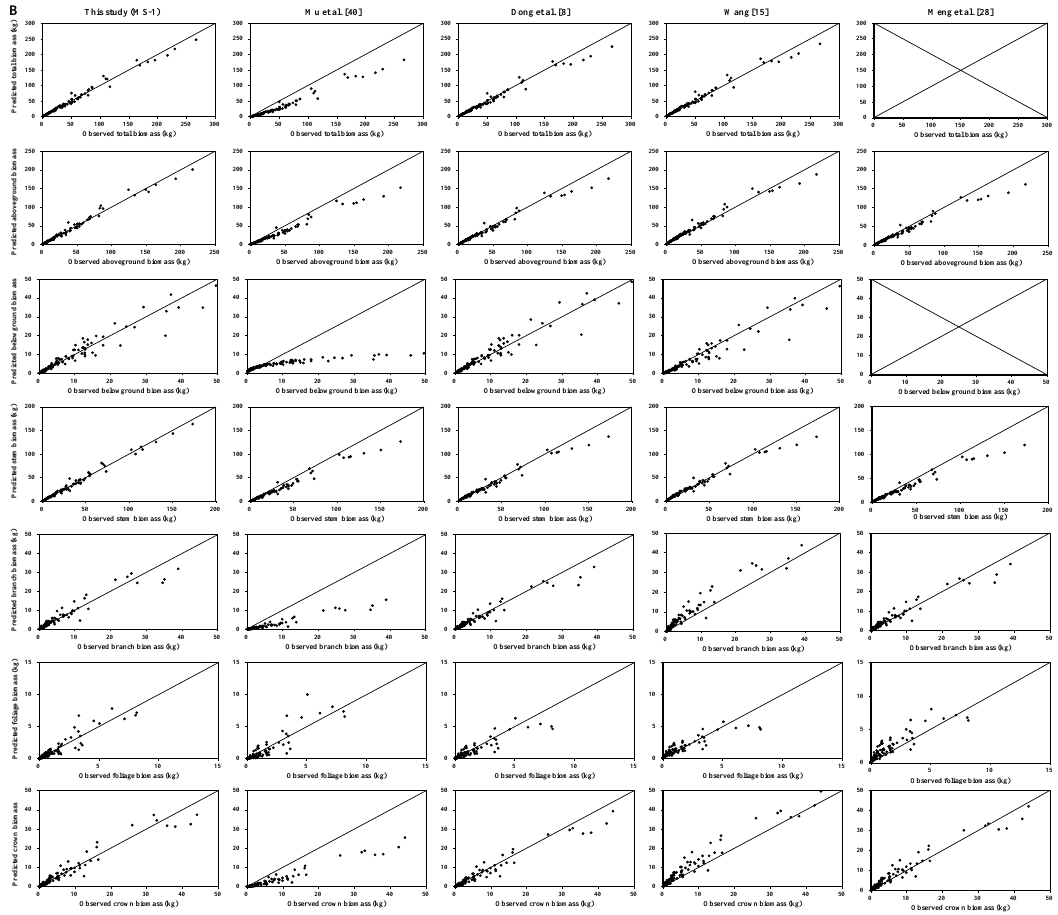
Figure 6. The observed data (black dots) and model predictions from our MS-1 and the previously published biomass models for total, subtotal, and component biomass for ( A ) Dahurian larch and ( B ) white birch. The previously published biomass models include Wang [15], Mu et al. [40], Dong et al. [8,22], and Meng et al. [28].